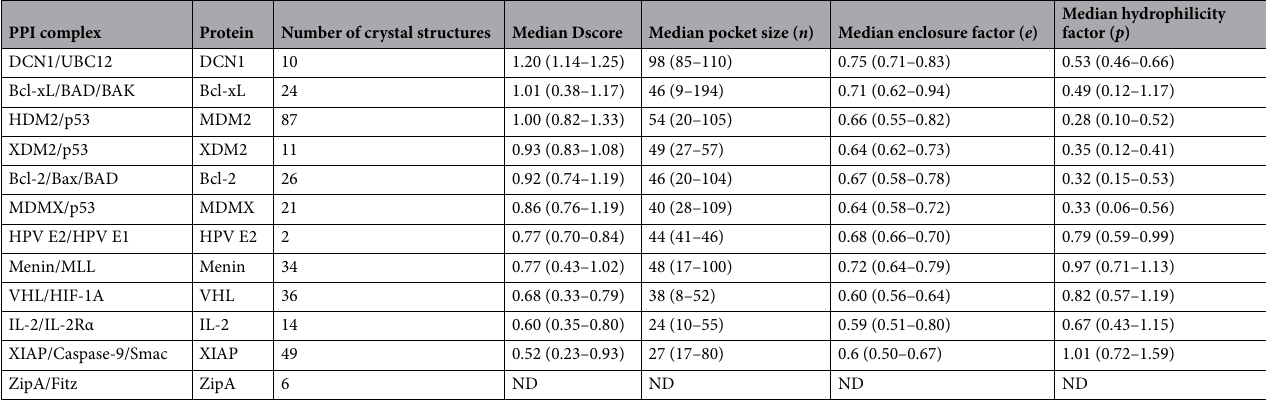
Table 2. SiteMap property and Dscore values for the 12 PPIs studied. Range in parentheses. ND: binding site was not detected by